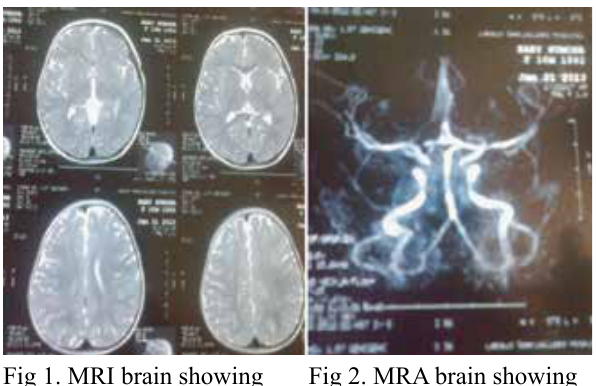
Fig 1. MRI brain showing normal findings